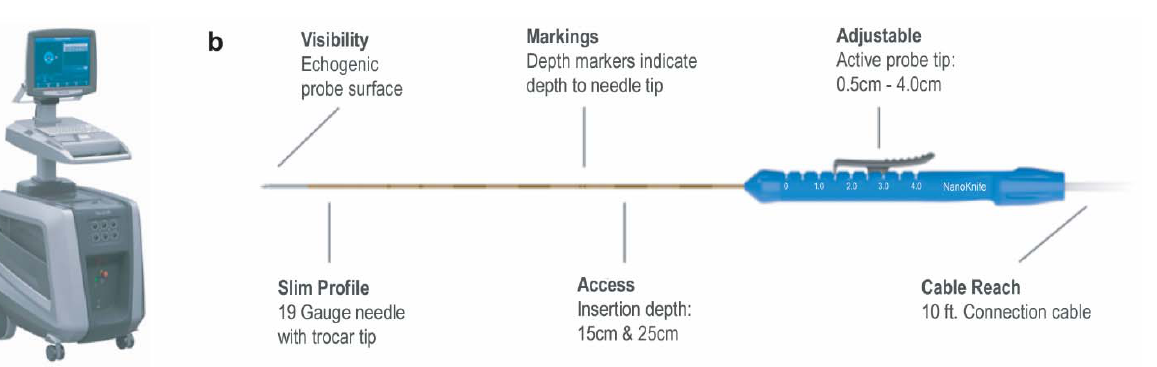
Figure 1. ( a ) The NanoKnife System. ( b ) NanoKnife IRE probe, 19-gauge needle with trocar tip with adjustable active probe tip ranging from 0.5 to 4.0 cm.